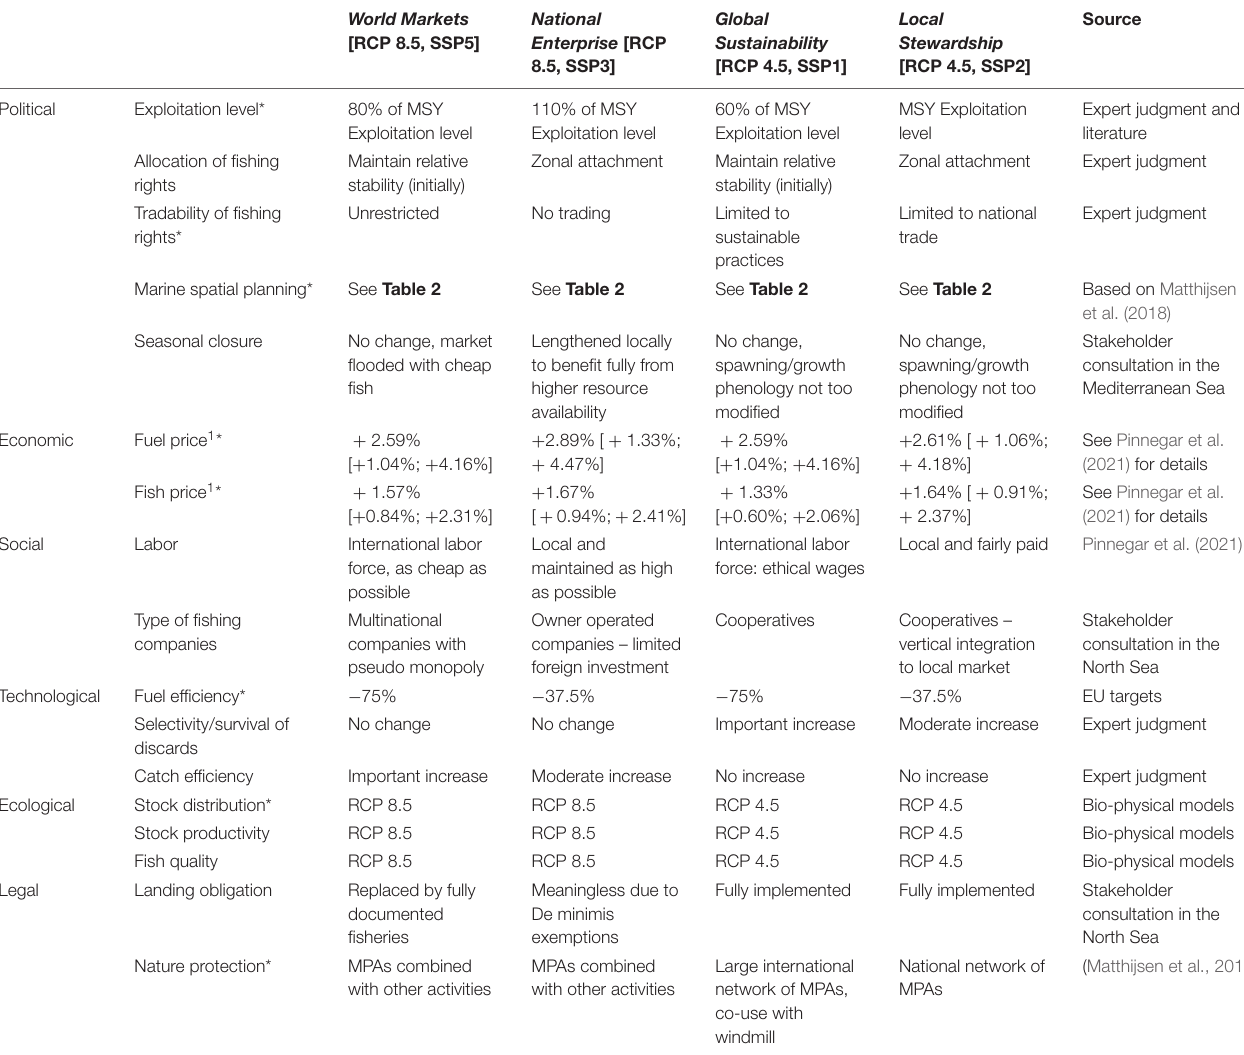
TABLE 1 | Political, Economic, Social, Technological, Ecological and Legal (PESTEL) variables and their differences among the four CERES